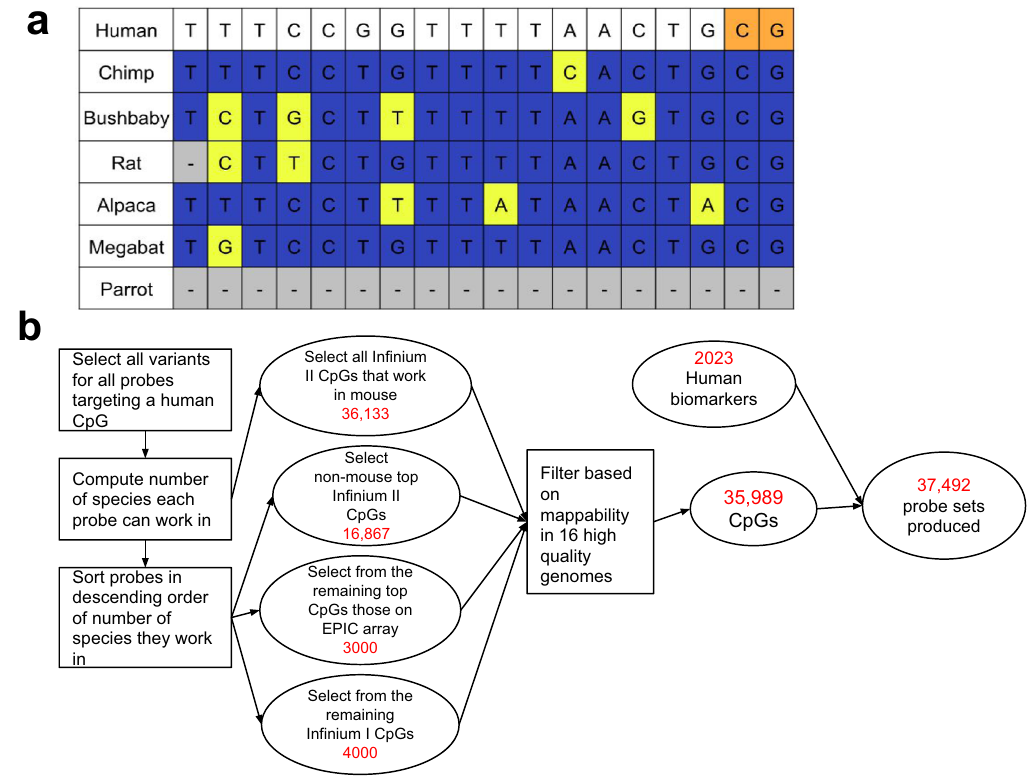
Fig. 1 Overview of mammalian methylation array design process. a Toy example of a multiple sequence alignment at a CpG site being considered by the CMAPS algorithm. The orange coloring highlights the CpG being targeted. Positions, where other species have alignment that matches the human sequence, are in dark blue; positions, where other species have alignment that does not match the human sequence, are in neon yellow; positions, where other species have no alignment, are in gray. b Flowchart detailing the selection of probes on the array by the CMAPS algorithm. A small fraction of probes designed were dropped during the manufacturing process. The number of selected CpGs in different sets were determined by biological considerations (e.g., suf fi cient numbers of Type I probes to capture CpG rich regions), statistical considerations (suf fi cient numbers of Type I probes for normalization methods), and costs of the resulting array (fewer than 40 K CpGs resulted in tolerable costs and Type II probes being more cost-effective than Type I